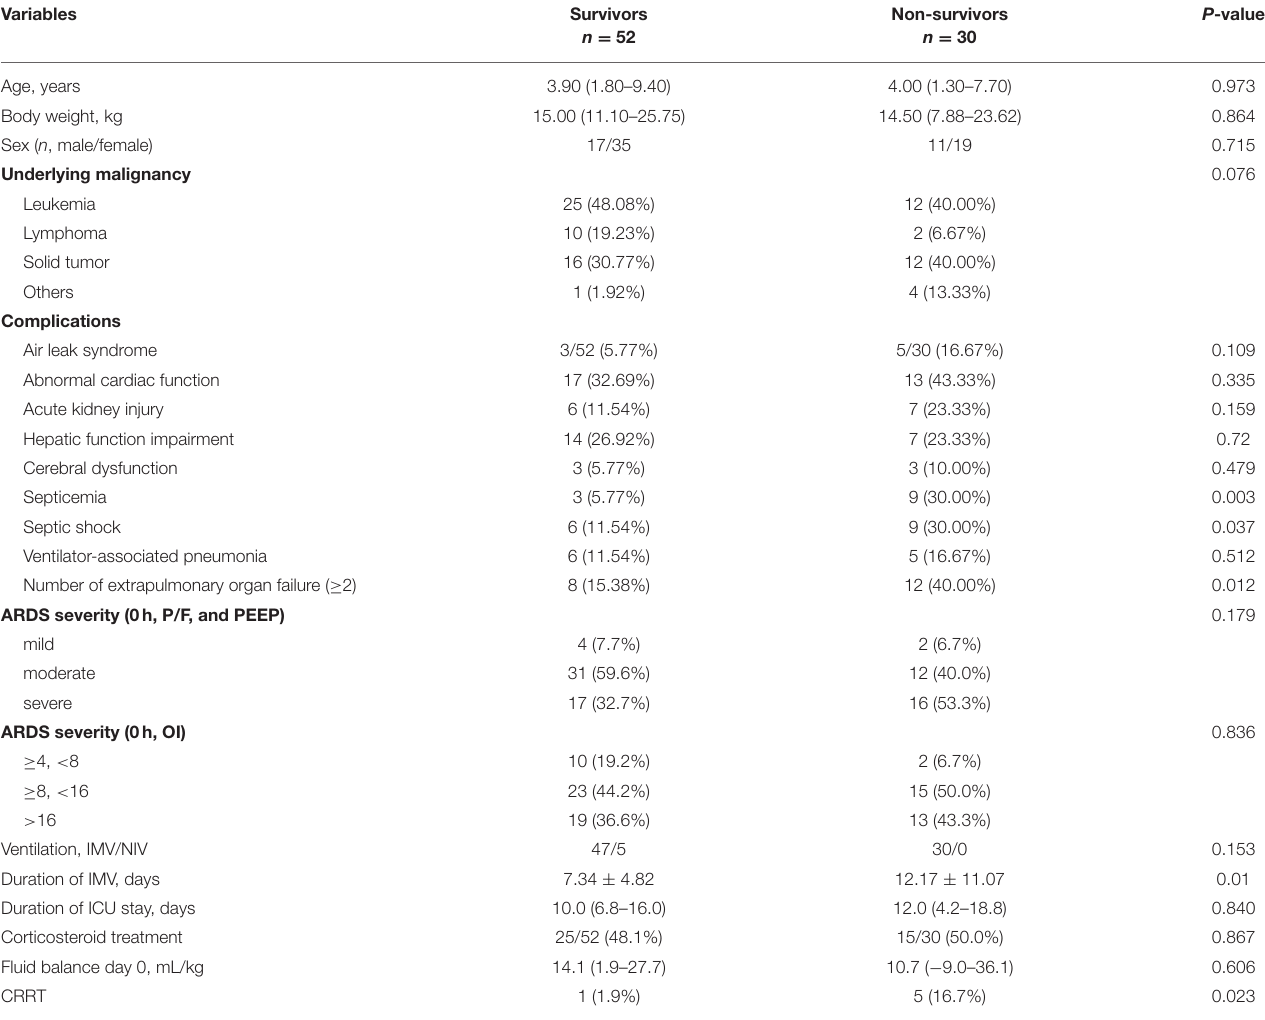
TABLE 1 | Comparison of patients’ clinical characteristics between the survivor and non-survivor groups.